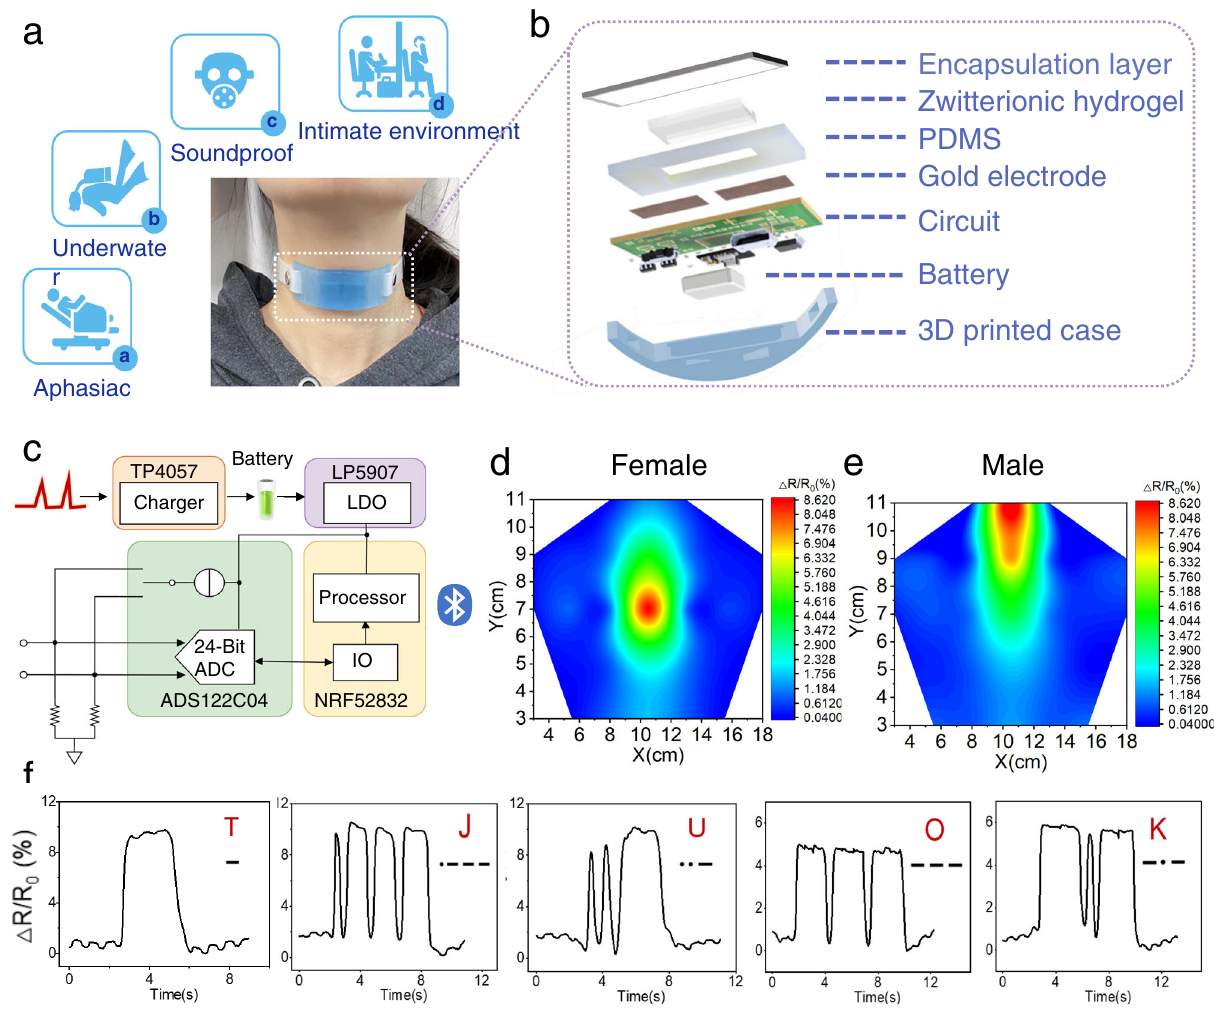
Fig. 5 | Schematics of the throat-worn silent-speech sensor and real-time speech signals. a Speci fi c situations serviced by silent-speech interfaces and a photograph of the throat-worn sensor used by a volunteer. b Expanded schematic ofthethroat-wornsensorshowingthezwitterionicsensinghydrogel,hollowPDMS elastomer, wireless printed circuit board, and enclosure architectures. c Circuit